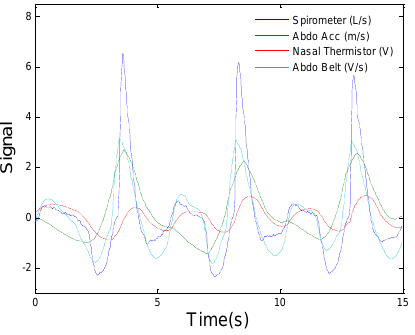
Fig. 1 Spirometer, integrated signal of accelerometer on abdomen, nasal thermistor and abdominal belt signals for 3 coughs and 2 quiet